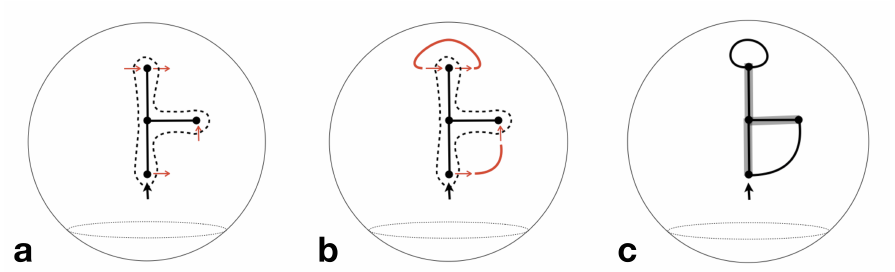
Figure 4. Mullin’s decoding: ( a ) Begin at what will be the root vertex, work in a counterclockwise circuit. Square parentheses direct drawing tree edges or moving along tree edges already drawn, and round parentheses direct decorating vertices with outward or inward arrows; ( b ) complementary arrows pair up to form the non-tree edges; and ( c ) the recovered tree-rooted plane graph.